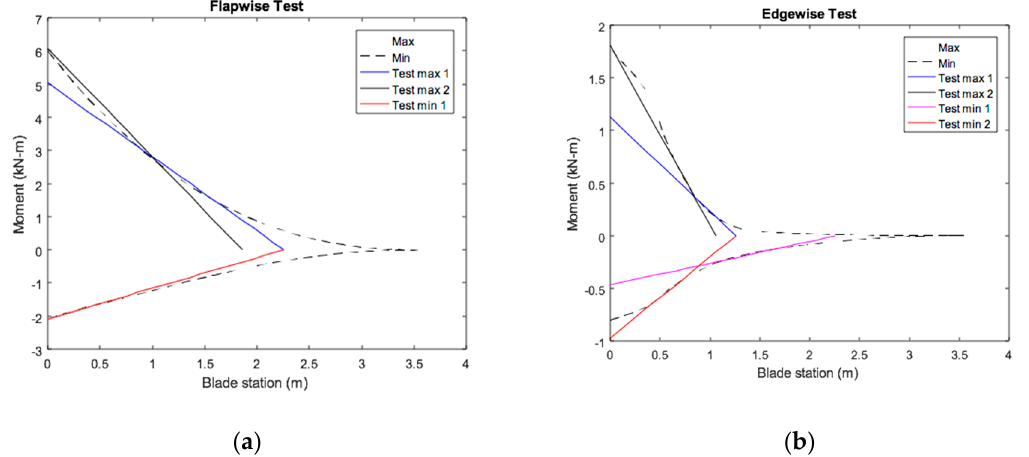
Figure 14. The test loads: ( a ) flapwise direction and ( b ) edgewise